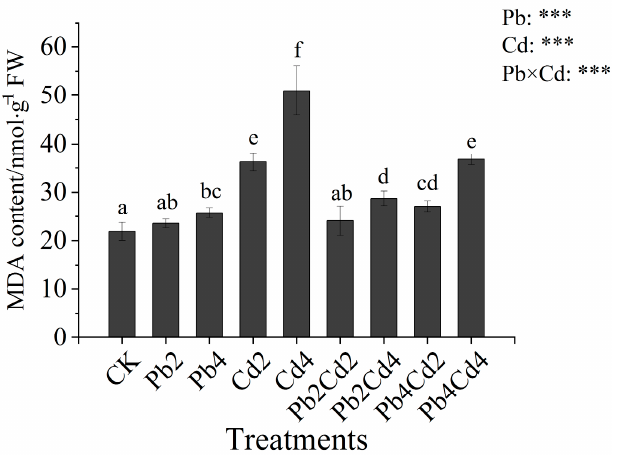
Figure 1. Effects of individual and combined Pb and Cd stress on malonaldehyde (MDA) content in F . parvifolia . The post hoc test used for the estimation of the significance level is the Duncan test. Different lowercase letters indicate significant differences at p < 0.05 between treatments. Each value represents mean values ± SEs (n = 5). ***, p < 0.001.